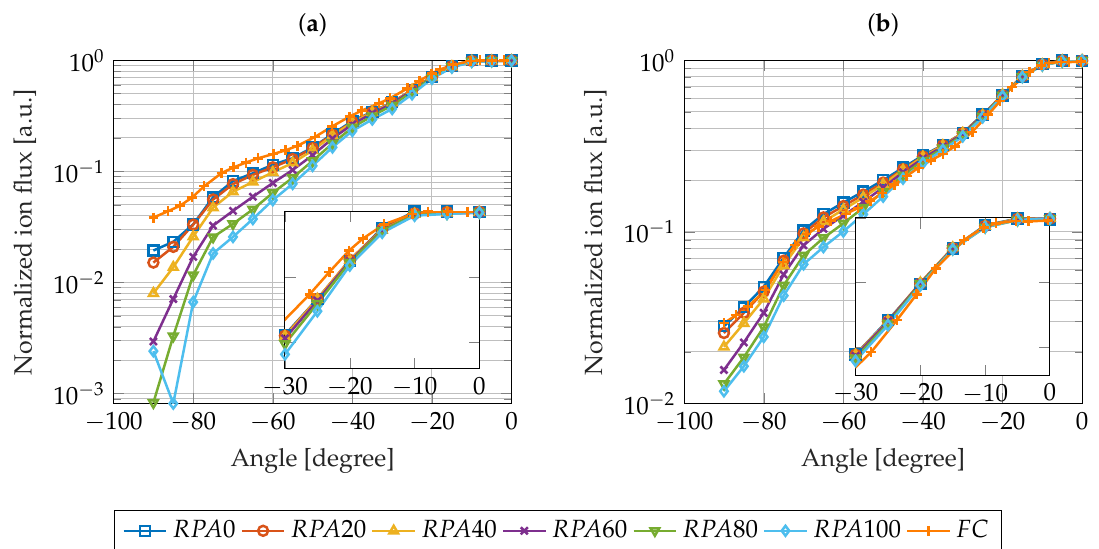
Figure 13. Normalized angular distribution of the ion flux recorded with a 4-grid RPA and the FC, at 200 V ( a ) and 300 V ( b ) applied voltages and a 5 sccm Xenon mass flow rate. The RPA curves correspond to different filter bias voltage, i.e., to different energy lower limits. The [ segment is shown in the insert for clarity’s